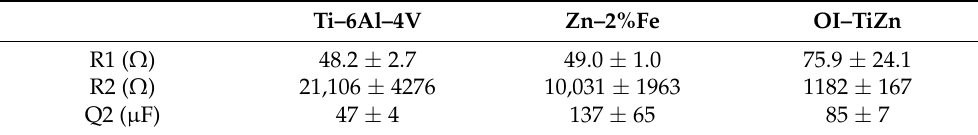
Figure 12. ( a ) Nyquist plots of Ti-base lattice, Zn–2%Fe alloy, and OI–TiZn system; ( b ) fitted electrical equivalent circuit (EEC). Table 3. The electrical equivalent circuit parameters fitted from the Nyquist plots.